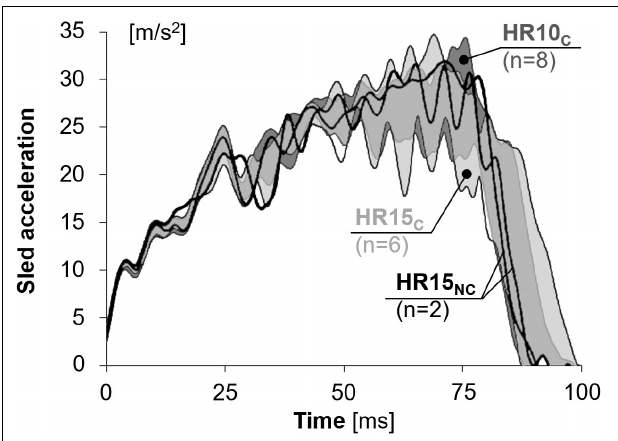
FIGURE 2 | The sled pulse for tests comprising 50th percentile female volunteers.